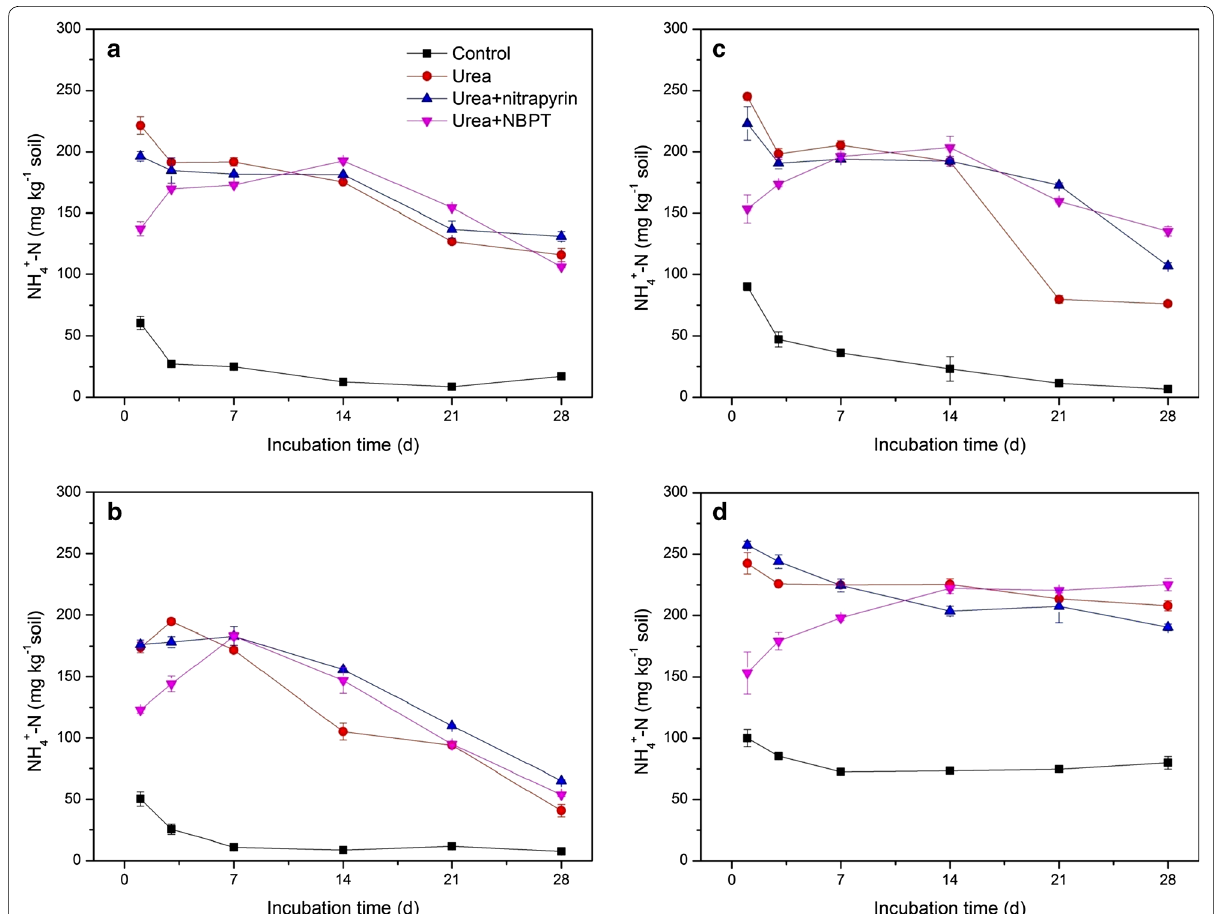
Fig. 1 The variation of NH 4 + ‑N concentrations as affected by applications of urea, nitrification inhibitor (nitrapyrin) and urease inhibitor (NBPT) at different pH levels. Error bars indicate standard deviation of mean ( n